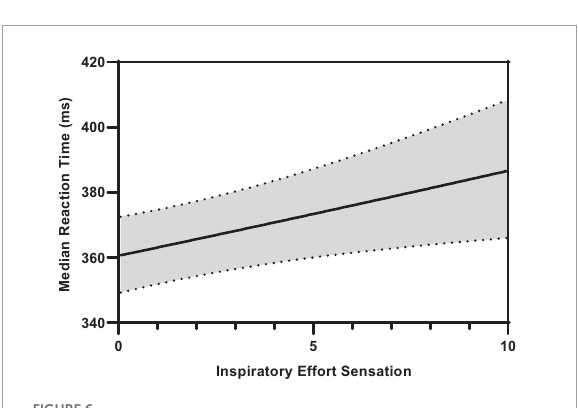
FIGURE6 Predicted smooth in median reaction time across inspiratory effort sensation. The predicted smooth of median reaction time was obtained from generalized additive mixed effects modeling (GAMM) of measures of median reaction time where inspiratory effort sensation, inspiratory PTP, and percent change in P ET O 2 , and P ET CO 2 were entered into the model as covariates. The predicted smooth curve was produced for median reaction time by setting all other covariates at their means (inspiratory PTP = –32.65 cmH 2 O · s; (cid:49) P ET O 2 = 7.31%; (cid:49) P ET CO 2 = –4.04%). The dashed curves show the 95% CIs around the